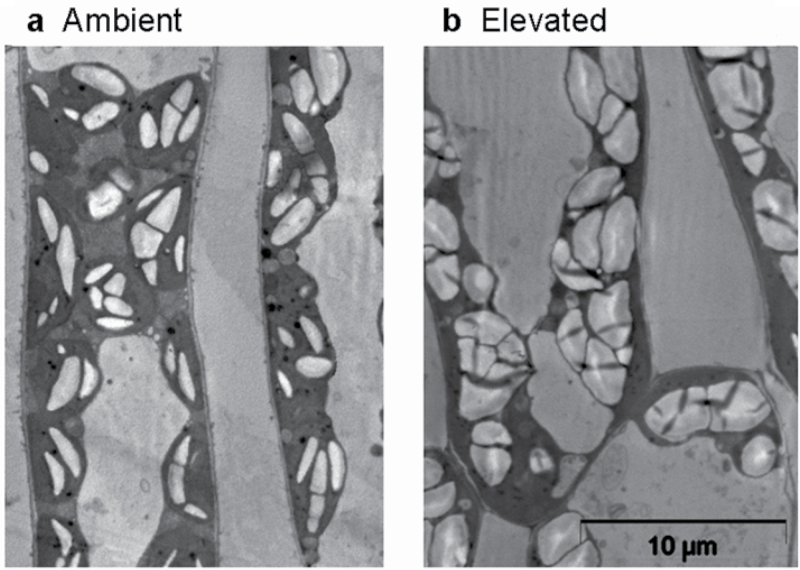
Transmission electron microscopy (TEM) images of leaf palisade mesophyll cells in hybrid aspen (P. tremula x P. tremuloides) leaves developed under the ambient CO2 concentration of 380 μmol mol−1 (a) and elevated CO2 concentration of 780 μmol mol−1 (b). The cells were viewed at 2100× magnification with a Philips Tecnai 10 TEM microscope (FEI, Eindhoven, Netherlands) using an accelerating voltage of 80kV.